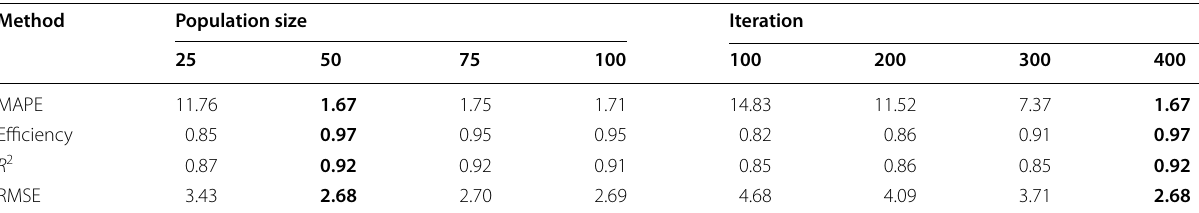
Table 10 Influence of various population sizes and iterations on PSO–DA